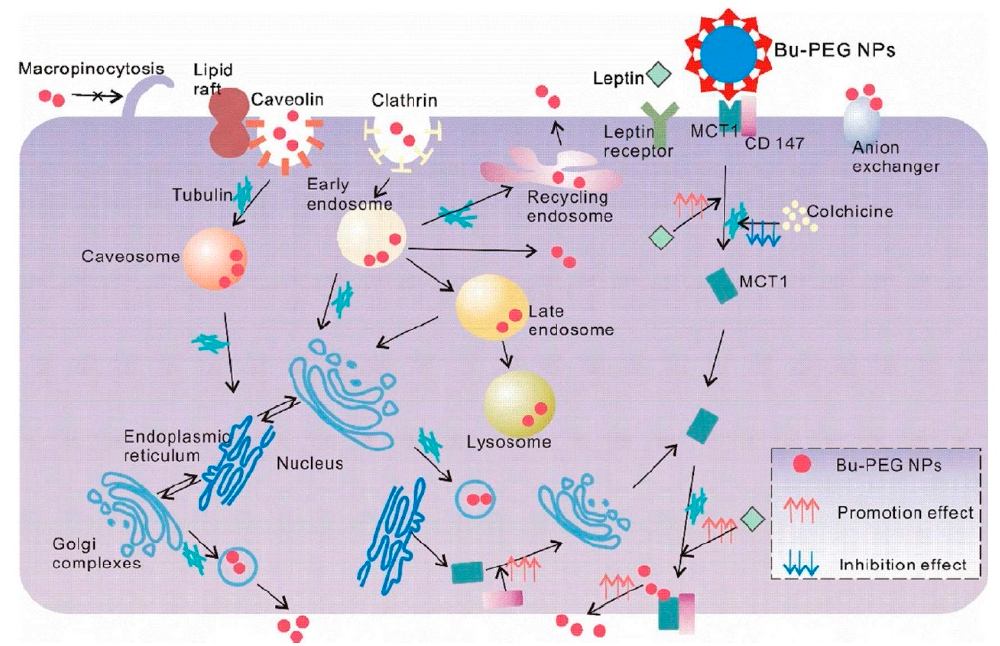
Figure 5. Transport pathways of butyrate-conjugated nanoparticles (Bu-PEG NPs) and factors that influence each stage of transcytosis. Reproduced with permission from [68]; Copyright 2018 American Chemical Society.